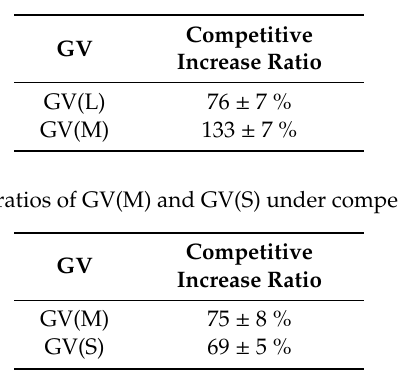
Table 2. Increase ratios of GV(L) and GV(M) under competitive condition.